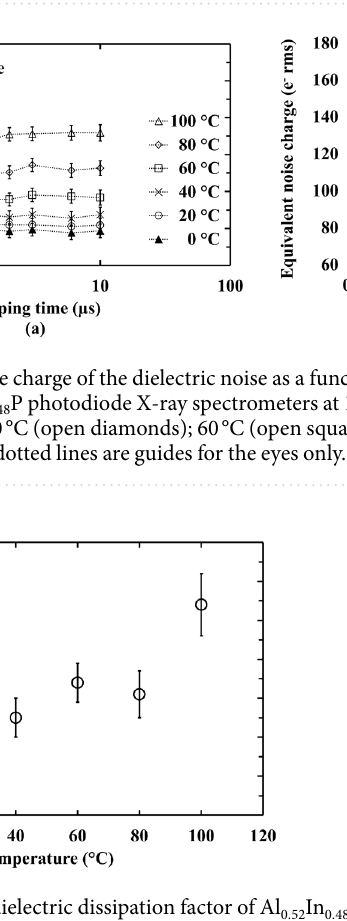
Figure 6. Equivalent noise charge as a function of shaping time for the Al 0.52 In 0.48 P photodiodes connected to the custom low-noise charge-sensitive preamplifier at 100 V reverse bias, at temperature of 100 °C and 0 °C; ( a , b ) for 217 μ m diameter photodiode at 100 °C and 0 °C, and ( c , d ) for 409 µ m diameter photodiode at 100 °C and 0 °C. Series white noise including induced gate current noise (open squares), parallel white noise (open triangles), Fano noise (dash line), and 1/ f series noise (open diamonds). The dotted lines are guides for the eyes only.